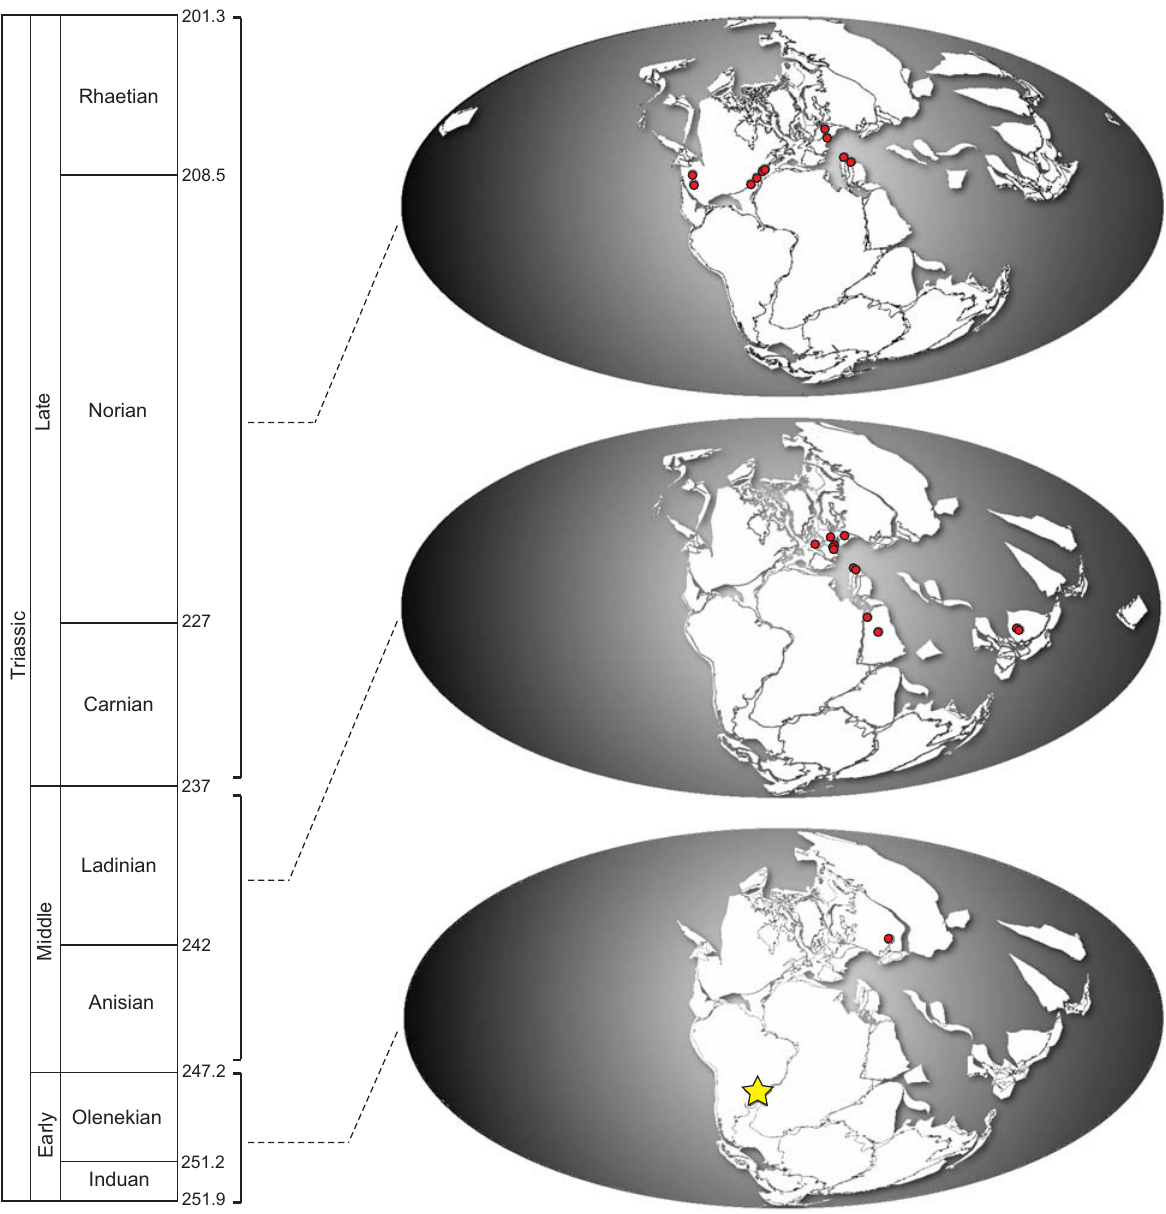
Fig. 5. Geographic distribution maps for Tanystropheidae through time (circles) and the brazilian fossil record (star) (data from the Paleobiology Database, https://paleobiodb.org/#/) and timescale from Gradstein et al.